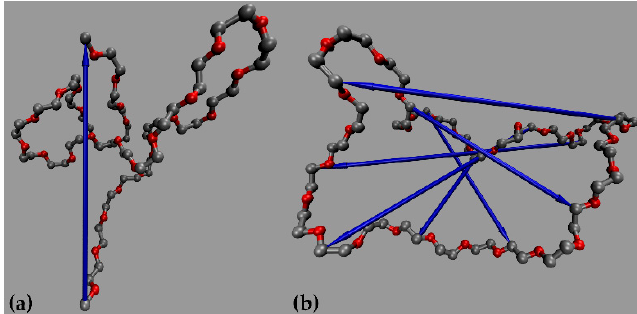
Figure 1. Definition of the characteristic vectors involved in the analysis of terminal orientational relaxation in linear and ring polymers. ( a ) The end-to-end vector R ee (blue arrow) in the case of a linear PEO chain, and ( b ) various diameter vectors R d (blue arrows) in the case of a ring PEO molecule. Grey and red beads indicate carbon and oxygen atoms along a PEO molecule, respectively.